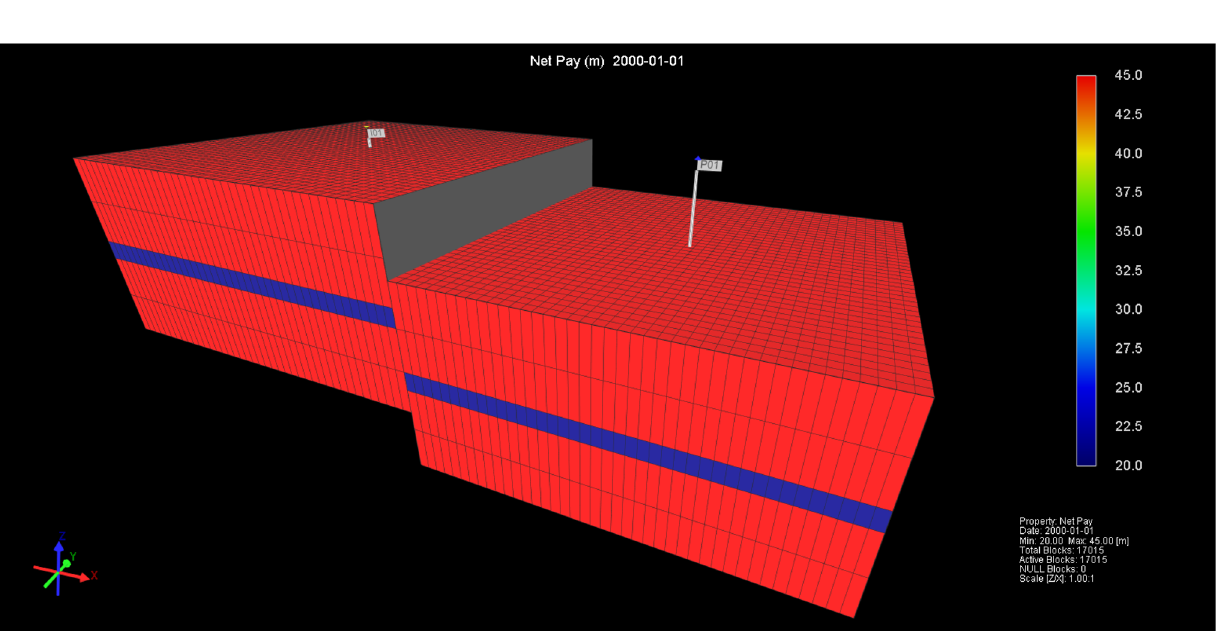
Fig. 10 3D view of the model of the sector of EOR 33 showing the fault and its